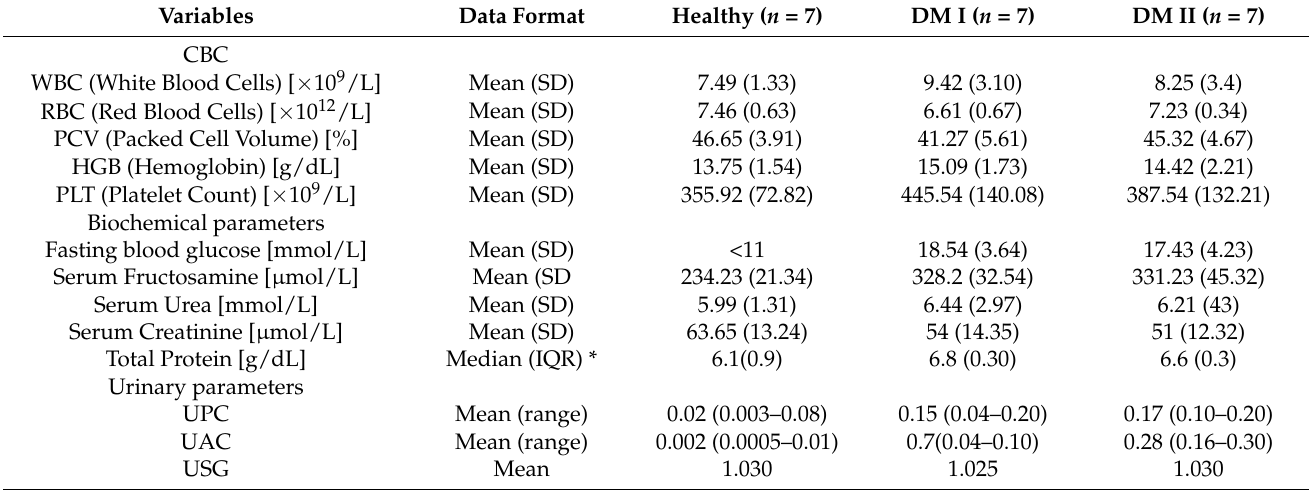
Table 1. Basic laboratory data of tested